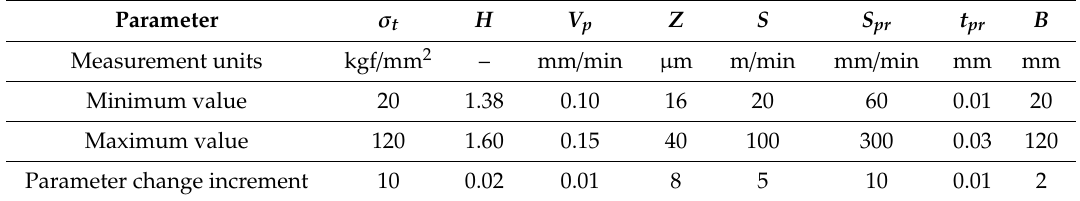
Table 1. Range of values and increments of changes of grinding